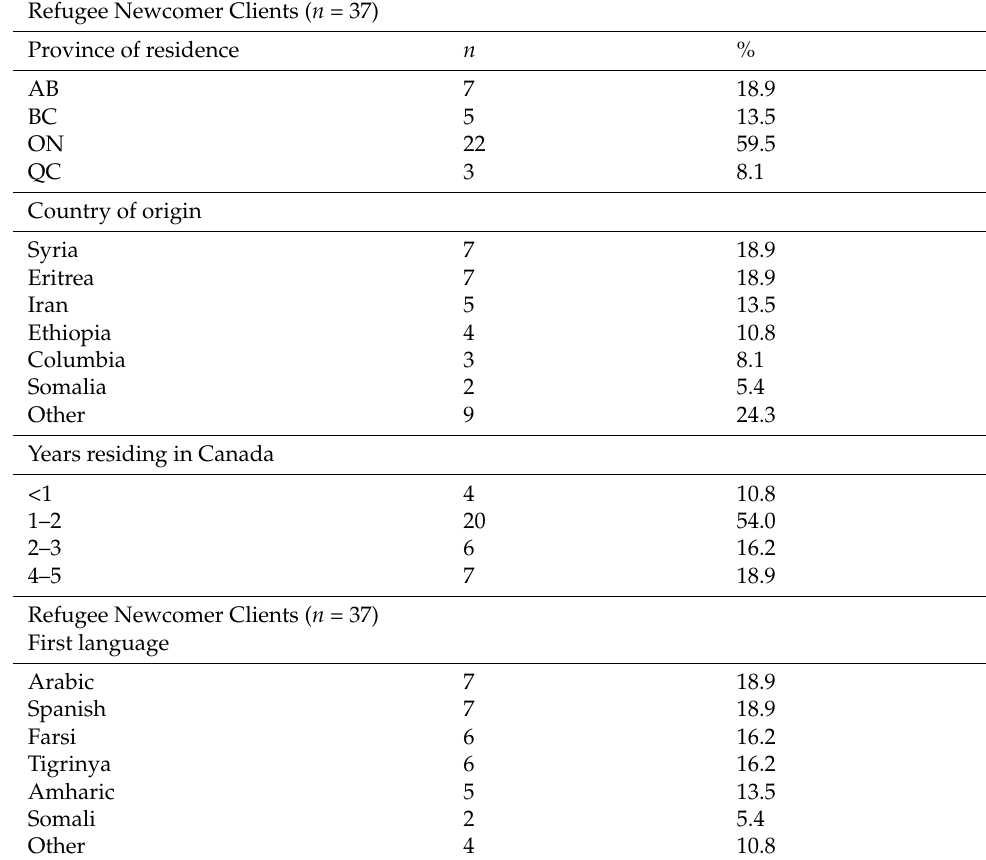
Table 2. Sociodemographic Information of Refugee Newcomer Clients ( n = 37). Refugee Newcomer Clients ( n =